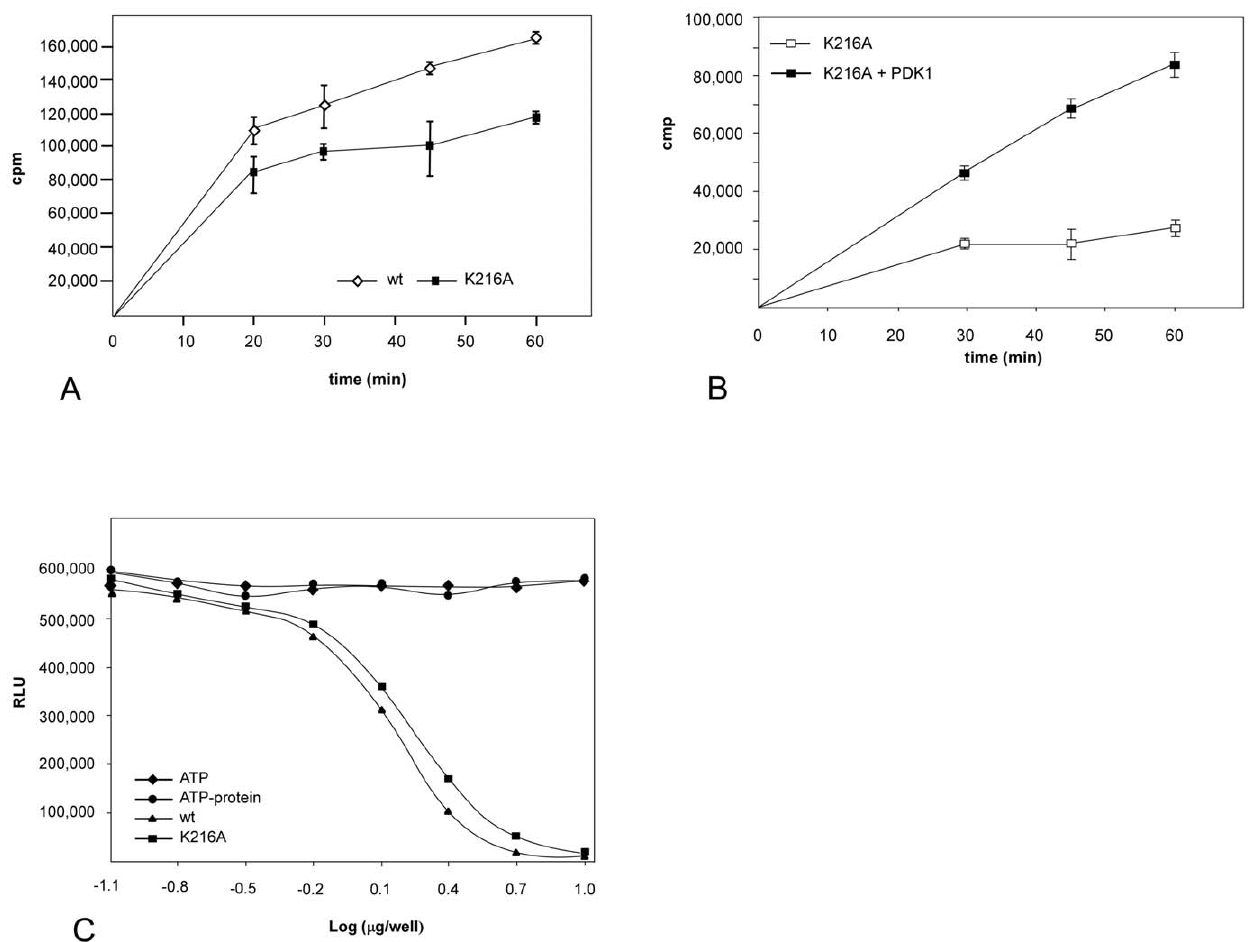
Figure 7. Comparison of wildtype NTD and K216A mutant phosphotransferase activity. ( A ) The K216A mutant showed a reduction of approximately 30% in activity toward the S6 peptide compared with wildtype. A kinetics assay was performed with a biotinylated S6 peptide and [ c - 32 P] ATP as described in Materials and Methods. ( B ) Pre-incubation with active PDK1 for 10 min stimulated K216A kinase activity about two fold in a similar pattern as the wildtype protein. ( C ) Kinase-Glo H luminescent kinase assay. The kinase titration was performed in the presence of ATP and the S6 peptide. Control experiments with ATP alone (no protein, no substrate) or ATP with protein (no substrate) are shown. Neither of proteins showed autophosphorylation activity. The control experiment with only substrate (no protein) showed the same luminescent signal as ATP alone and is not shown in the graph. All experiments were reproduced several times.